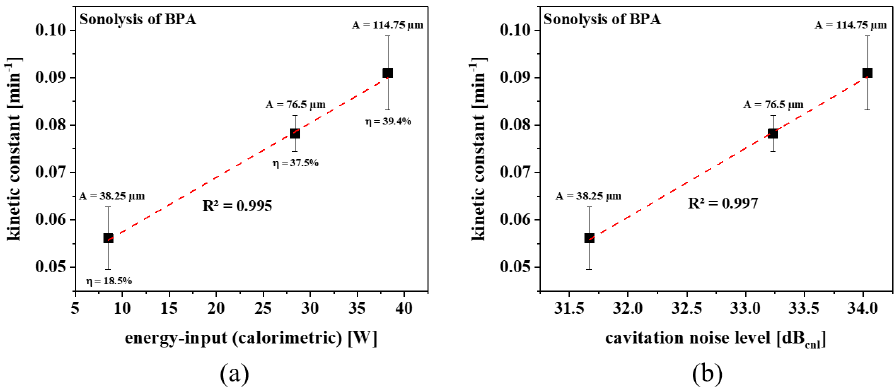
Figure 3. Correlation between sonolytic rate constants ( a ) and ultrasonic energy input considering the energy − conversion efficiency [ η ] and ( b ) the cavitation noise level measured in the near field of the oxidizing cavitation area.